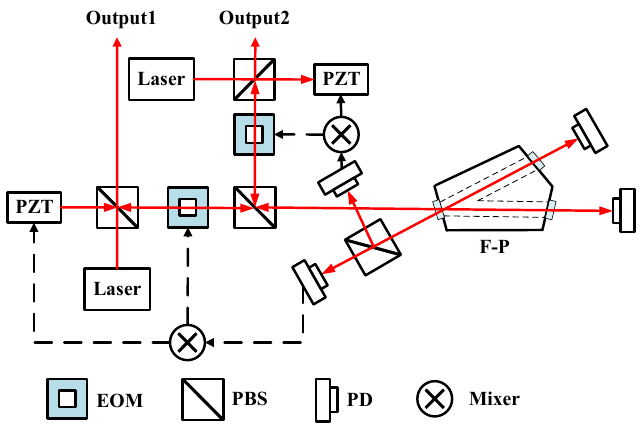
Figure 7. Scheme of the narrow linewidth laser setup. EOM: electro–optic modulator; PBS: polarizing beam splitter; PD: photo detector; PZT: piezoelectric transducer. (Figure reproduced from [61].)